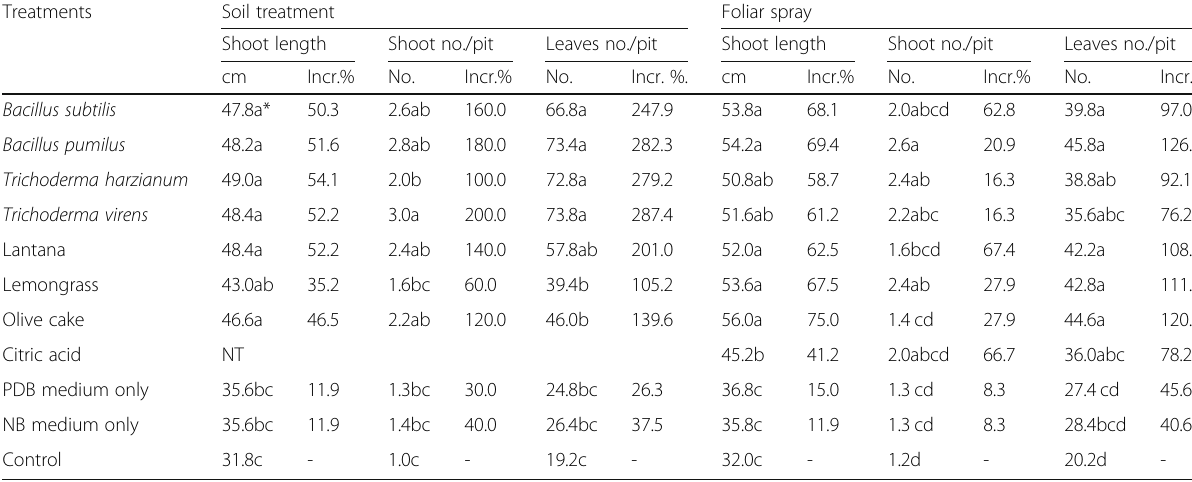
Table 2 Effect of bio-control agents, aqueous plant extracts, and citric acid as soil treatments and/or foliar spray on shoot parameters of potato plants in field application Treatments